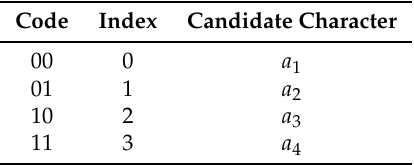
Table 1. The encoding result of the candidate character set.